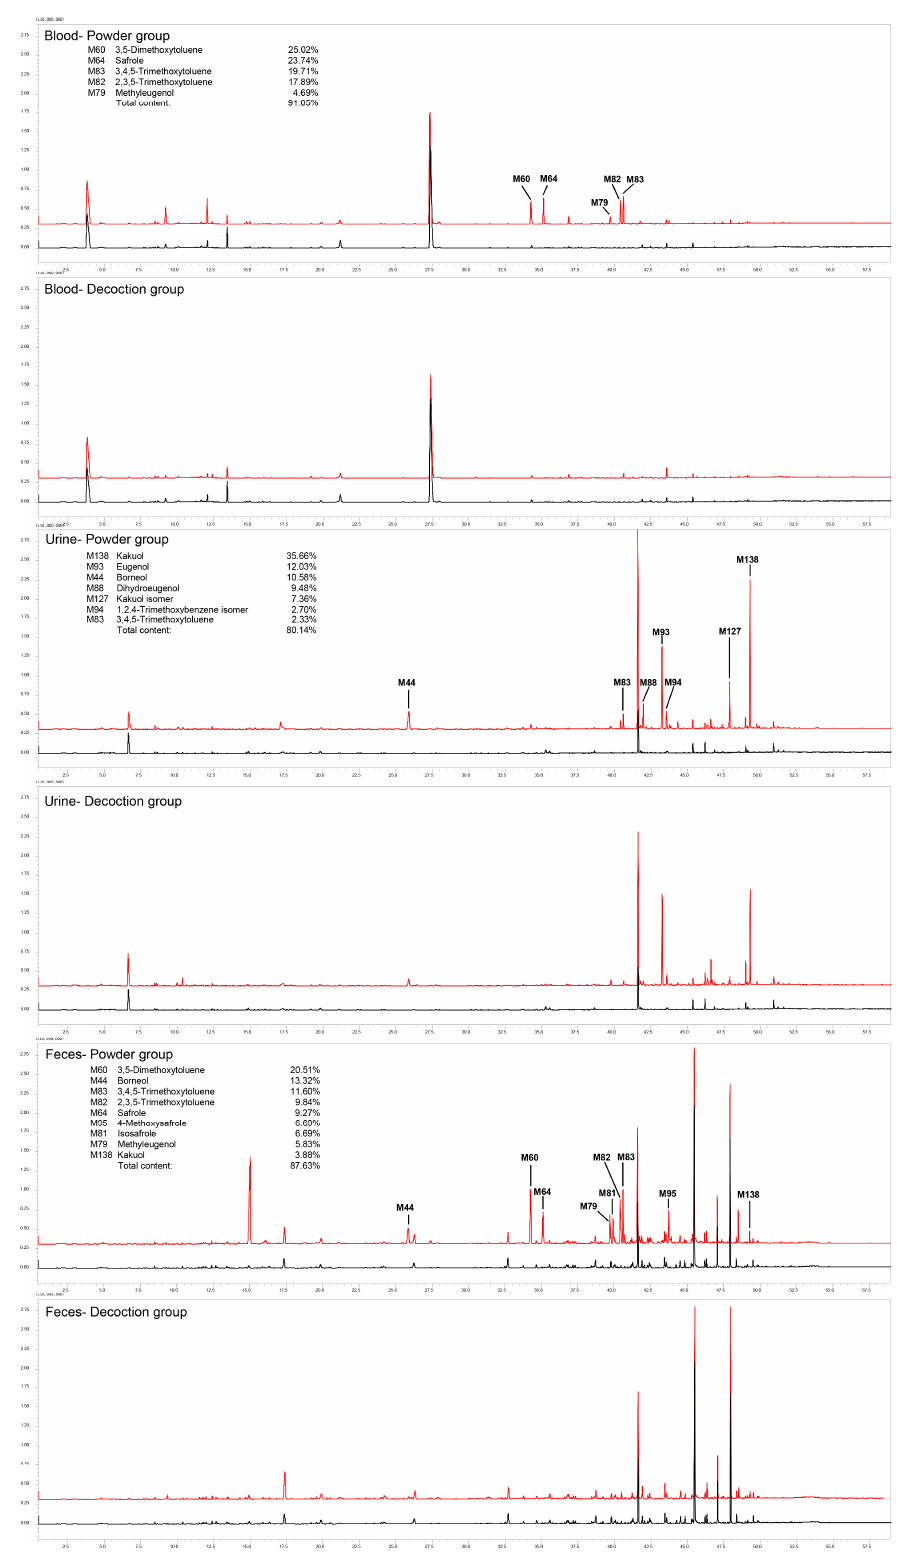
Figure 1. Total ion chromatograms (TICs) of compounds identified in blood, urine, and feces of rats after oral administration of ARR powder or decoction by HS–SPME–GC–MS. Contents were calculated from extracted ion chromatography (EIC) according to area generalization method. Red line: treatment group; black line: control group.